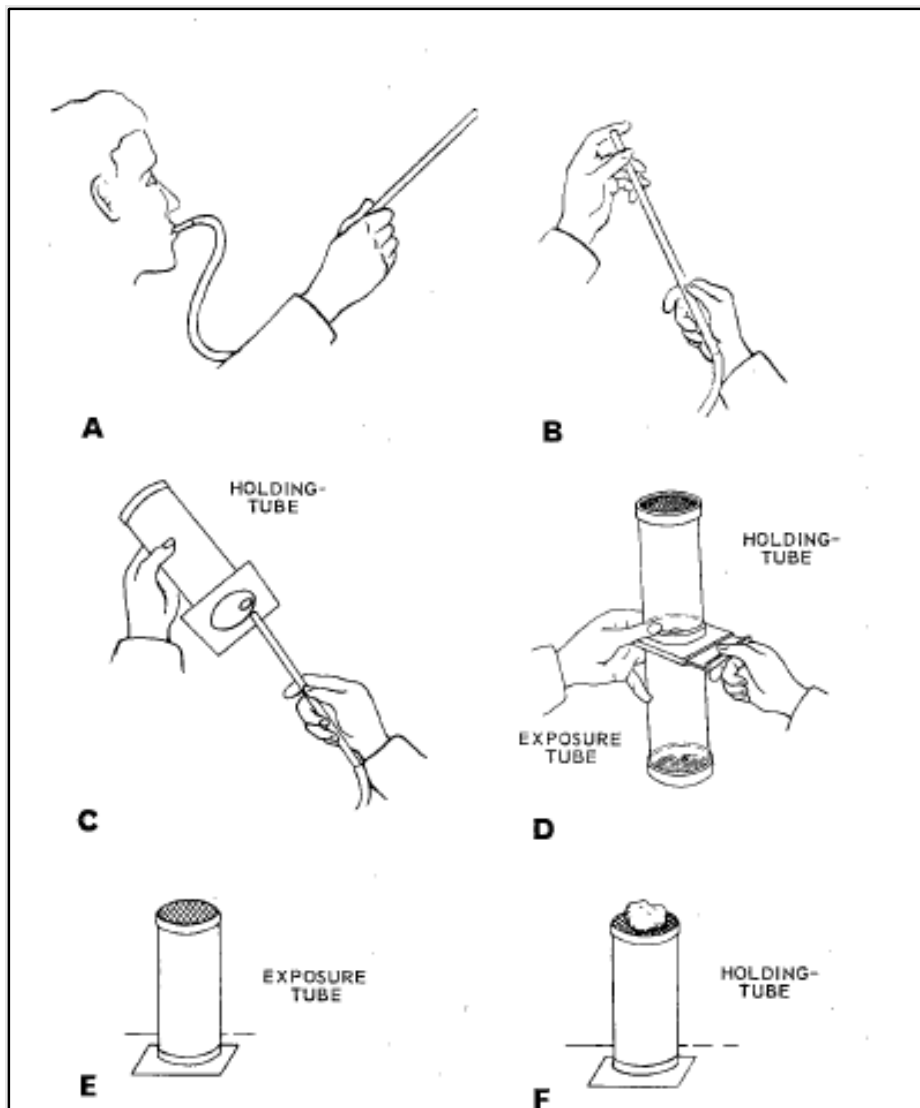
Figure 2. Original World Health Organization (WHO) tube method as outlined in the “8th Report of the Expert Committee on Insecticides” [24], reproduced with permission of Rajpal Singh Yadav, WHO. ( A ) Collect test mosquitoes using a mouth aspirator. ( B ) Mosquitoes should be collected in batches of no more than 10. ( C ) Test mosquitoes are gently transferred to the holding-tubes until they number 20–25 per tube. ( D ) The exposure tube is attached, and the slide is opened. Mosquitoes are then gently blown from the holding-tube to the exposure tube. The holding-tube is detached and set aside ( E ) The exposure tubes are left standing upright for 1 h during the exposure. ( F ) Mosquitoes are transferred back to the holding-tube by reversing the process described in C. The holding-tube is set upright, and a pad of wet cotton wool is placed on top. Tubes are held for 24 h, at which point mortality counts are made.